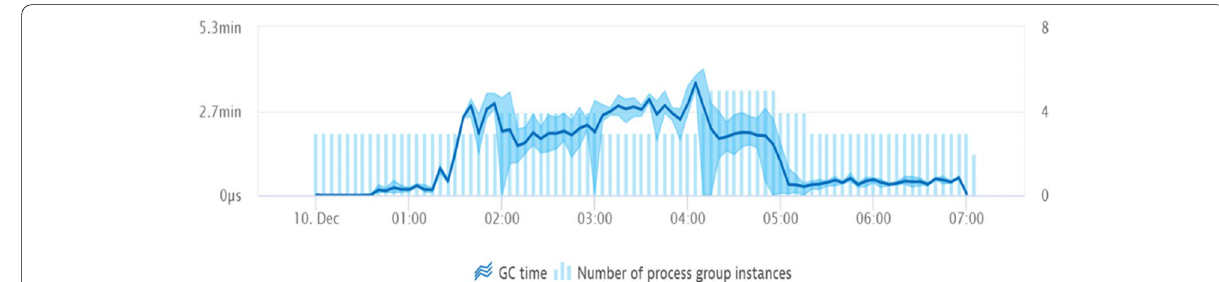
Fig. 28 Garbage collection time vs. number of monolith frontend instances